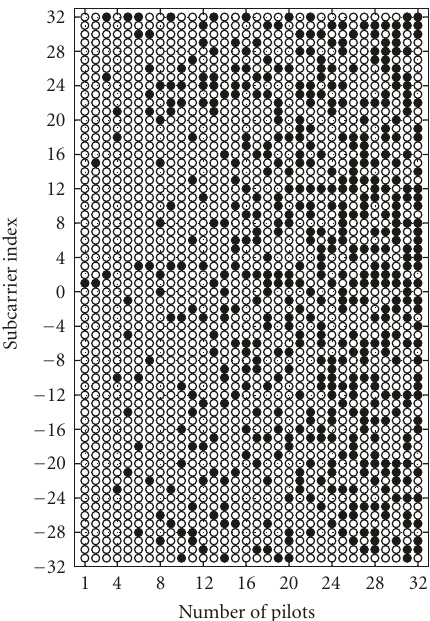
Figure 6: Pilot locations that minimize the ACF sidelobe peak for the unconstrained search. Pilot locations for P > 32 can be obtained directly using this figure from the complementary set theorem. For example, the configuration for P = 40 pilots is obtained by interchanging black and white circles of the configuration for P = 24 (64 − 40 = 24).